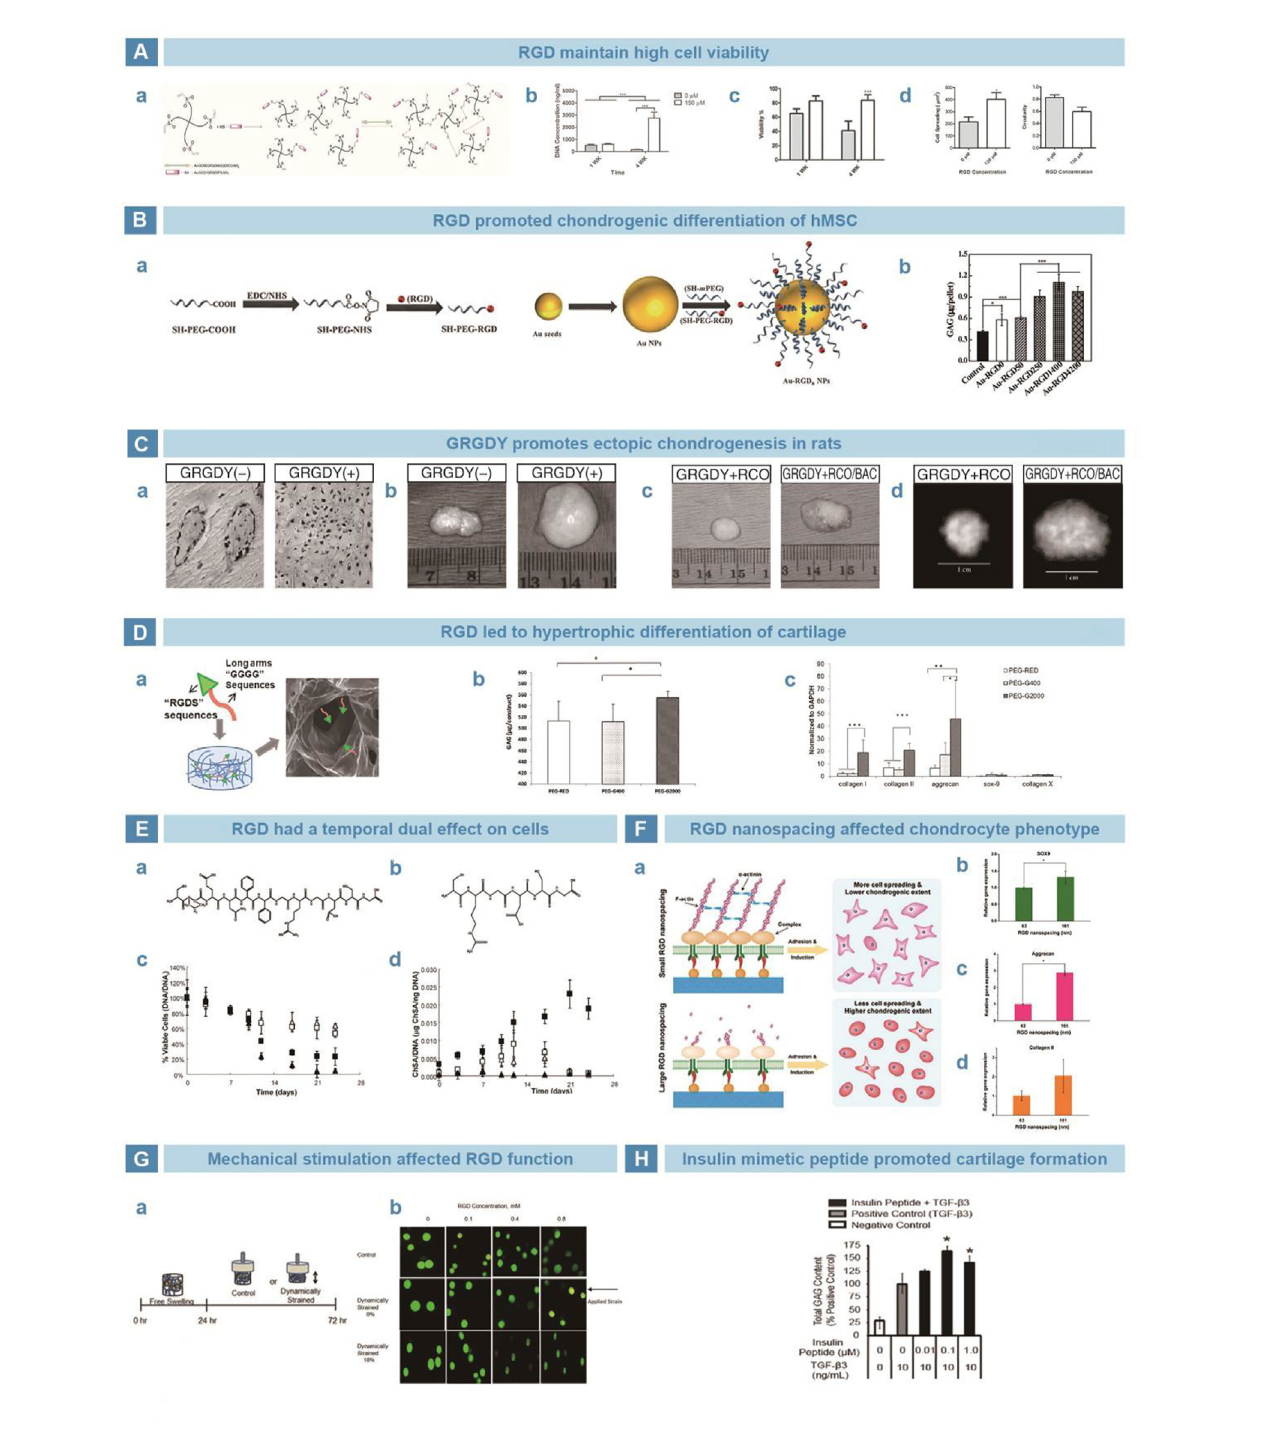
FIGURE 6 Peptides mimicking integrin and insulin in cartilage restoration. (A) . RGD sequence functioned the PEG-VS was crosslinked via di-thiol crosslinker (A) . Supplemented by RGD, cells survived and proliferated better (B – C) . Besides, the upregulation of cell spreading and downregulation of cell circularity con fi rmedthesatisfyingcelladhesion (D) (Kudvaetal.,2018). (B) .PeptideRGDwasconjugatedontoAu-nanoparticals (A) .Au-RGD1400stimulationexhibited higher deposition of GAGs (B) (Li et al., 2017b). (C) . Peptide G-RGD-Y stimulated chondrocytes turned out typical collagen distribution by Masson stain (A) . The bovine articular chondrocytes and calvarial osteoblasts were mixed and loaded into RGD-modi fi ed alginate scaffold, which turned into neocartilage oflarger size (B) ,mass (C) andhigh-densityimageunderX-ray (D) (Alsberg etal.,2002). (D) . RGDsequence waschemically crosslinkedwithPEG (A) , resulting in more secretion of GAGs (B) . However, a trend of hypertrophy in chondrocytes was found after stimulation of peptide RGD (C) (Zhang et al., 2015b). (E) . Chemical formulas of enzymatically cleavable peptide CPENFFGRGDSG (A) and uncleavable peptide CRGDSG (B) . Enzymatically cleaved CPENFFGRGDSG showed limited long-term in fl uence on cell viability (C) . With stimulation of CPENFFGRGDSG, the secretion of GAGs was signi fi cantly improved (D) (Salinas and Anseth, 2008). (F) . RGD was grafted on PEG hydrogel to stimulate MSCs (A) . Expression of chondrogenic genes on different nanospacings after 10 days (B – D) (Li et al., 2015). (G) . Dynamic mechanical loading was exerted on MSCs after 24-h cultivation (A) . RGD alleviated the trend of morphology change after straining (B) (Villanueva et al., 2009). (H) . Insulin-derived peptide of 0.1 μ M improved the deposition of GAGs, with the presence of TGF- β 3 (Renner and Liu,